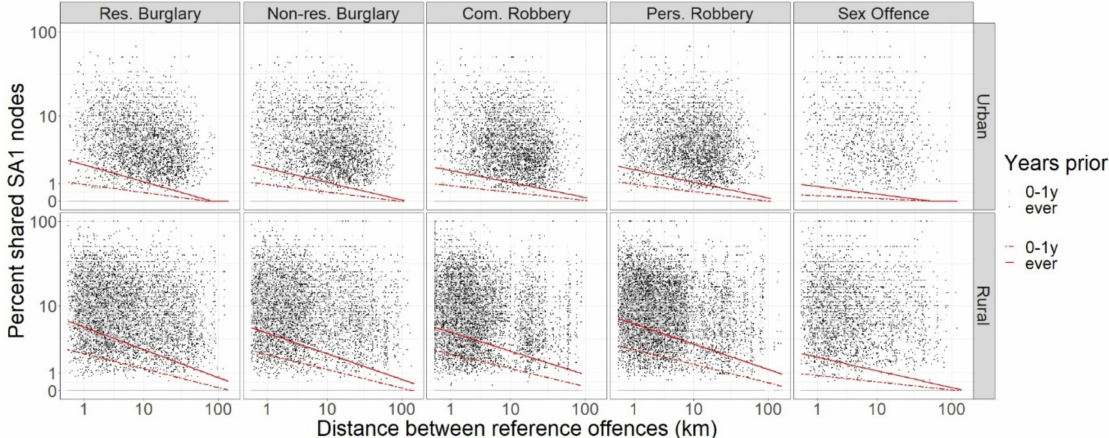
Figure 5. Proportion of activity space shared between pairs of offenders by distance between their reference offenses.